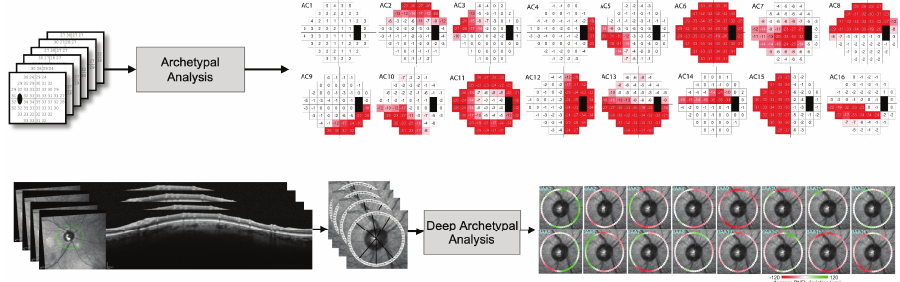
Figure 3. Visual field (VF) and optical coherence tomography (OCT) image quantification. Top: VFs were quantified to 18 prominent patterns of VF loss based on classical archetypal analysis. Bottom: OCT circle scans were quantified to 16 patterns of RNFL loss based on deep archetypal